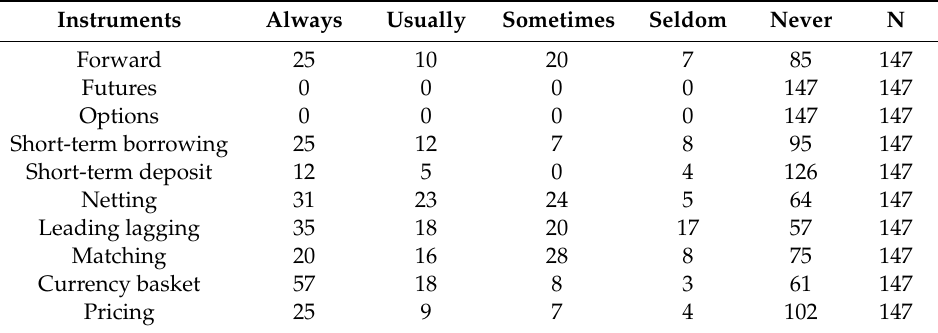
Table 2. Kuwaiti firms’ responses to their use of hedging instruments.